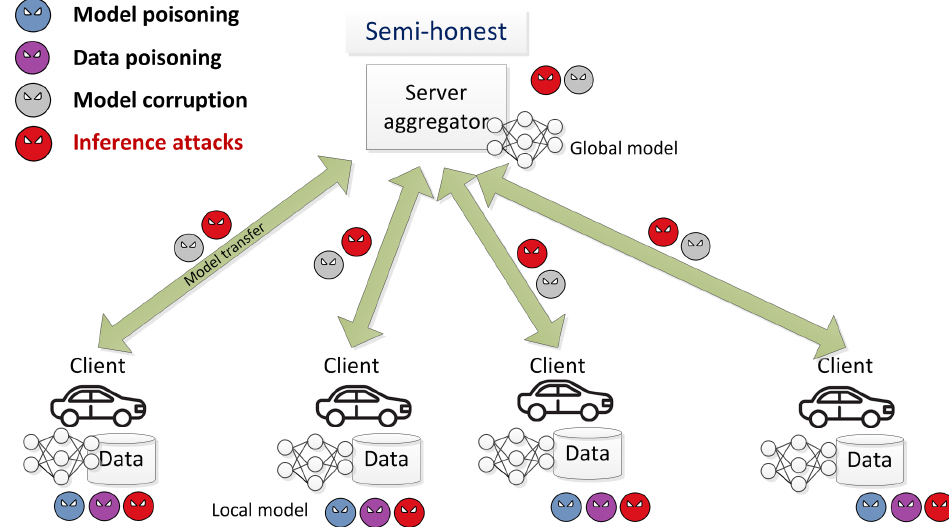
Figure 1. FL components and attack entry points during the training